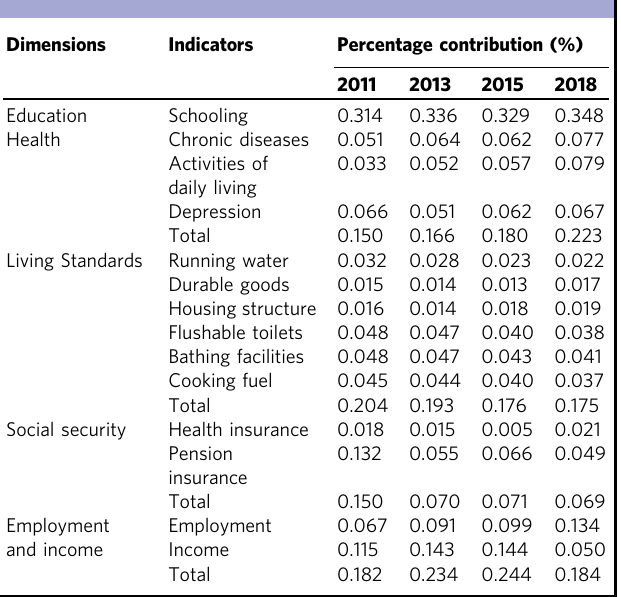
Table 4 Contribution of the selected indicators to